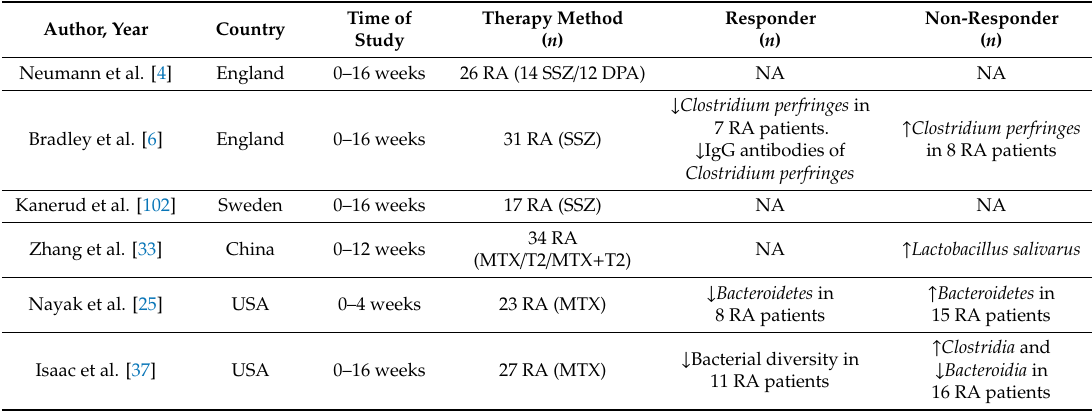
Table 3. E ff ect of DMARDs on the gut microbiota and the phenotype to therapy in RA